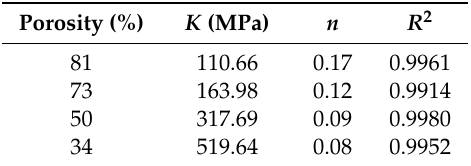
Table 5. Average values of coe ffi cients and exponents of the monotonic, e ff ective hardening curve of Ti6Al4V titanium alloy diamond structure with di ff erent